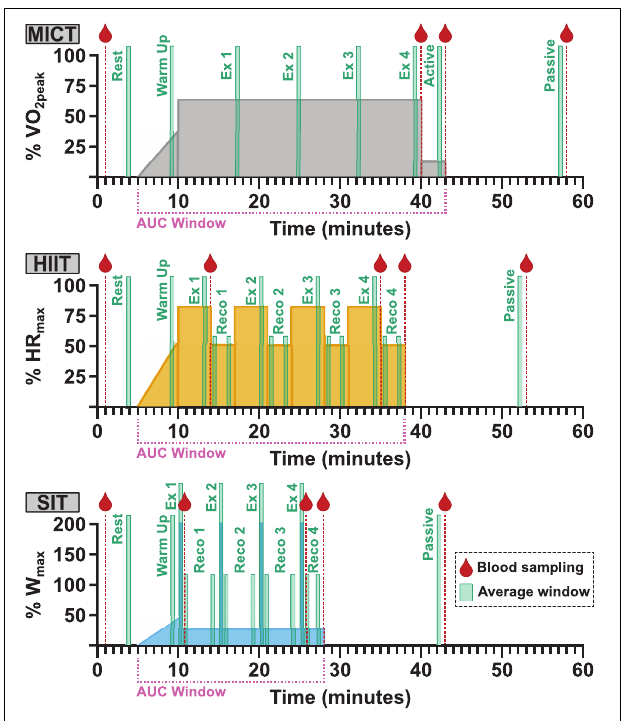
FIGURE 1 | Participants took part in three separate exercise visits in a randomized order, consisting of 30 min of moderate, steady-state exercise at 65% VO 2 peak (MICT); four 4 min high intensity intervals at 85% HR max (HIIT); and four 30 s supramaximal sprint intervals at 200% W max (SIT). All protocols were preceded by 5 min of seated rest and a 5 min warm-up, and followed by 3 min of active recovery at 50 W and 15 min of seated passive recovery. The timing of blood sampling (red droplet), data averaging windows, and labels for analysis (green boxes) and the period used in area under the curve (AUC) analysis (pink bracket) are included for all protocols. Averaging was carried out over 30-second windows across the course of each exercise protocol (Ex) and during the initial and final minute of recovery (Reco) following each HIIT and SIT bout. The final 30-second recovery window in both HIIT and SIT was taken as the active recovery timepoint, in conjunction with the active recovery window (Active) in MICT. VO 2 peak , maximum oxygen consumption; HR max , maximum heart rate; W max , maximum aerobic